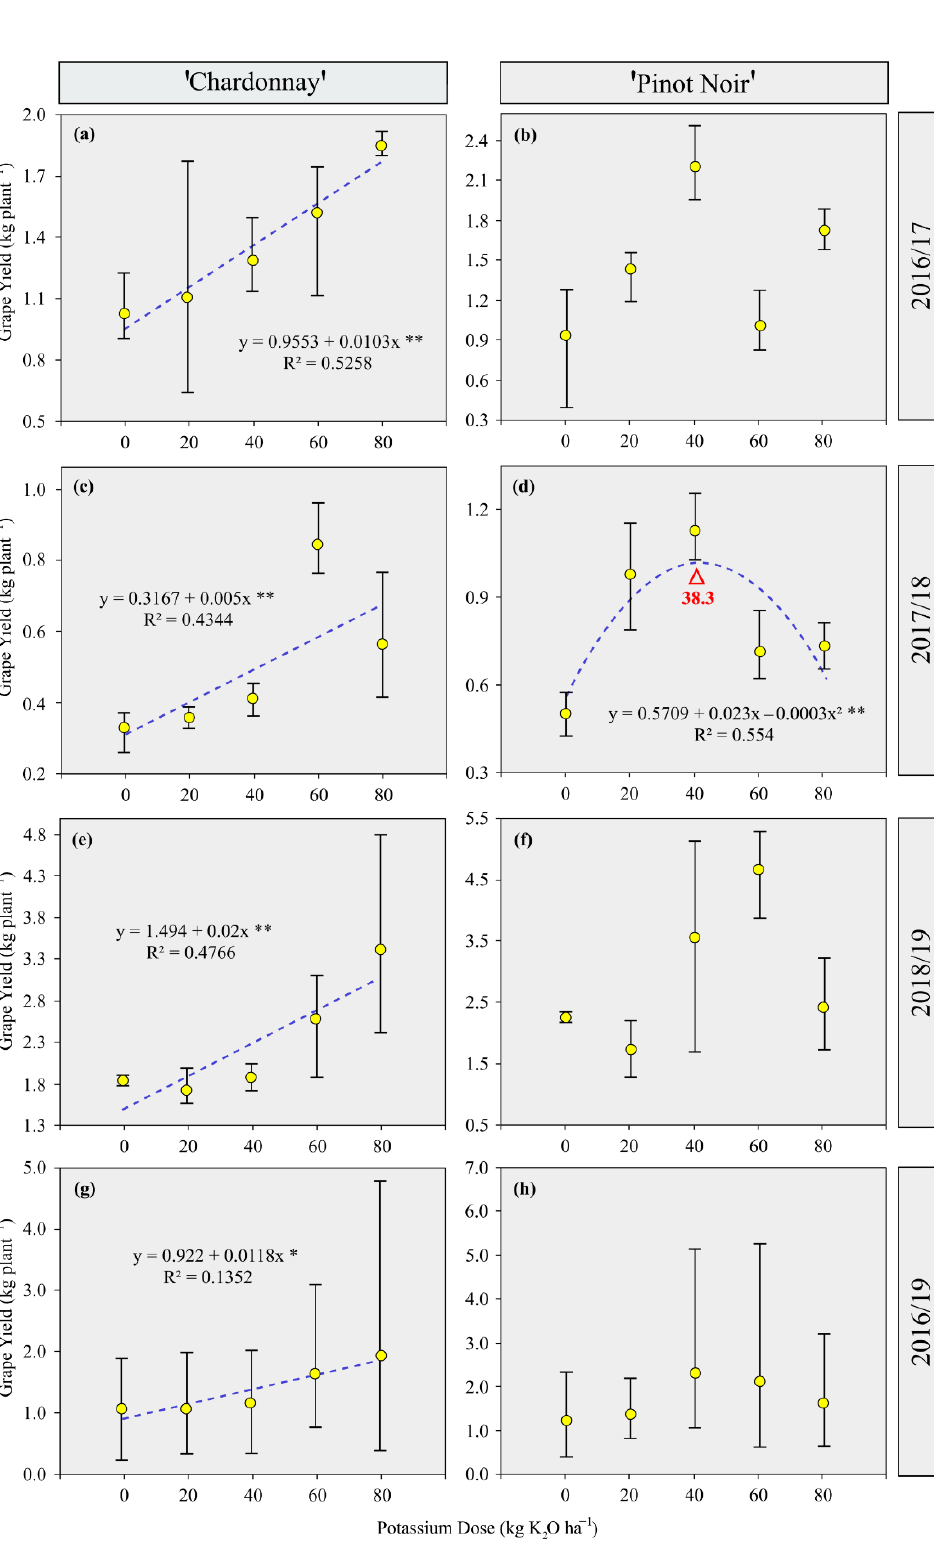
Figure 9. Potassium maximum technical efficiency (MTE) doses in relation to the grape yield of ‘Chardonnay’ ( a , c , e , g ) and ‘Pinot Noir’ ( b , d , f , h ) in 2016/17, 2017/18, 2018/19 and in a compilation of the crop seasons submitted to the application of soil fertilized with K. The blue dotted line is the behavior of the equation. “*” Significant at 5% ( p < 0.05). “**” Significant at 1% ( p < 0.01).